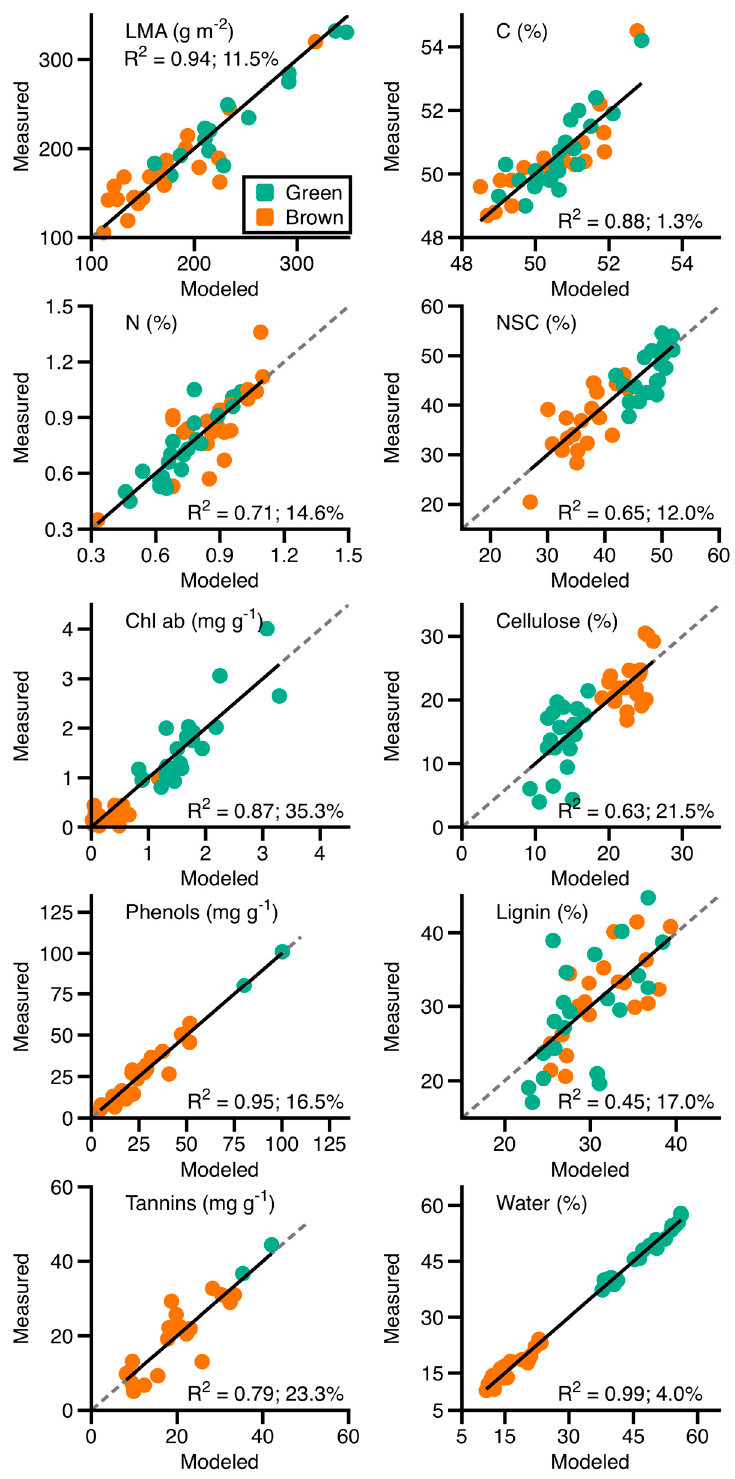
Figure 5. Accuracy and precision of reflectance-based analyses of traits for green and brown ʻ ō hi ʻ a foliage. The more separable a given trait, the more important its role in determining spectral differences associated with fungal infection leading to Rapid Ohia Death. Fewer phenol and tannin data points for green foliage is due to a lack of sampling as described in the methods.